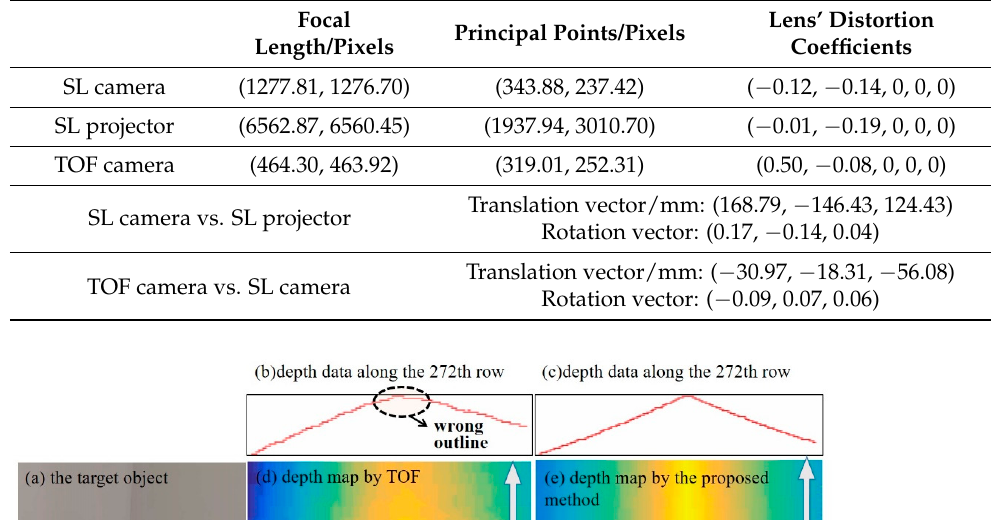
Figure 9. Reconstruction results of the spherical surface. ( a ) the target object; ( b ) estimated depth by TOF along the 240th row; ( c ) estimated depth by the proposed method along the 240th row; ( d ) estimated depth map by TOF; ( e ) estimated depth map by the proposed method; points clouds reconstructed by ( f ) DCSL; ( g ) TOF; and ( h ) the proposed method respectively. To evaluate the results quantitatively, experimental data were analyzed and are provided in Table 2. Note that for two perpendicular planes, the number of reconstructed point clouds, the angle between the two planes, and the plane fitting errors were designated as the key indicators to evaluate the reconstruction effect. As for the spherical surface, the number of reconstructed point clouds, the sphere fitting error, and the diameter’s estimation error were designated as the key indicators.